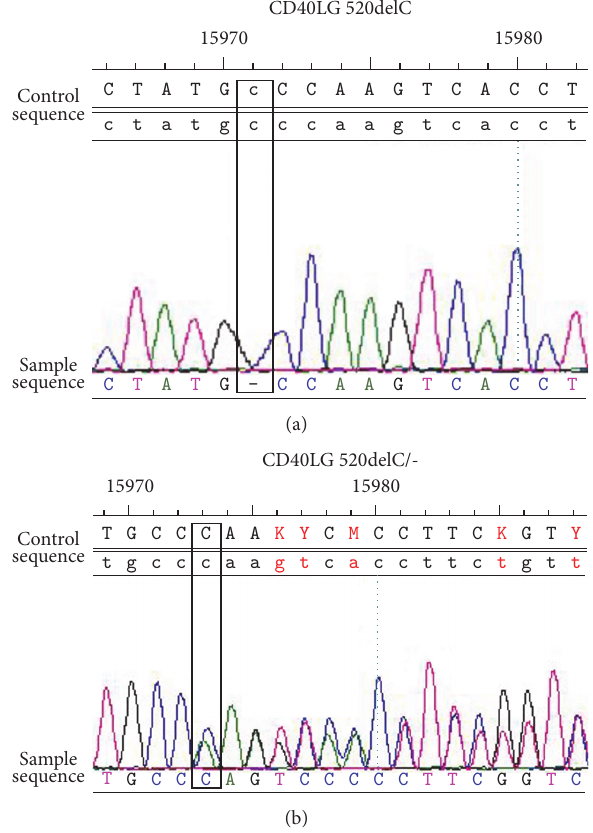
Figure 3: CD40LG gene analysis of the patient and his mother. CD40LG gene analysis showed the deletion mutation of cytidylic acid residue at position 520 in exon 5 region in the patient (a). The patient’s mother carried the same mutation